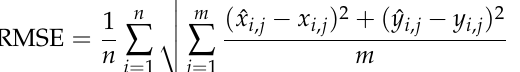
(cid:17)(cid:12) (cid:12) (cid:12) and the threshold while the right y-axes show the true and detected ] = [ 0,1 ] , ∆ y (cid:48)(cid:48) 1 1